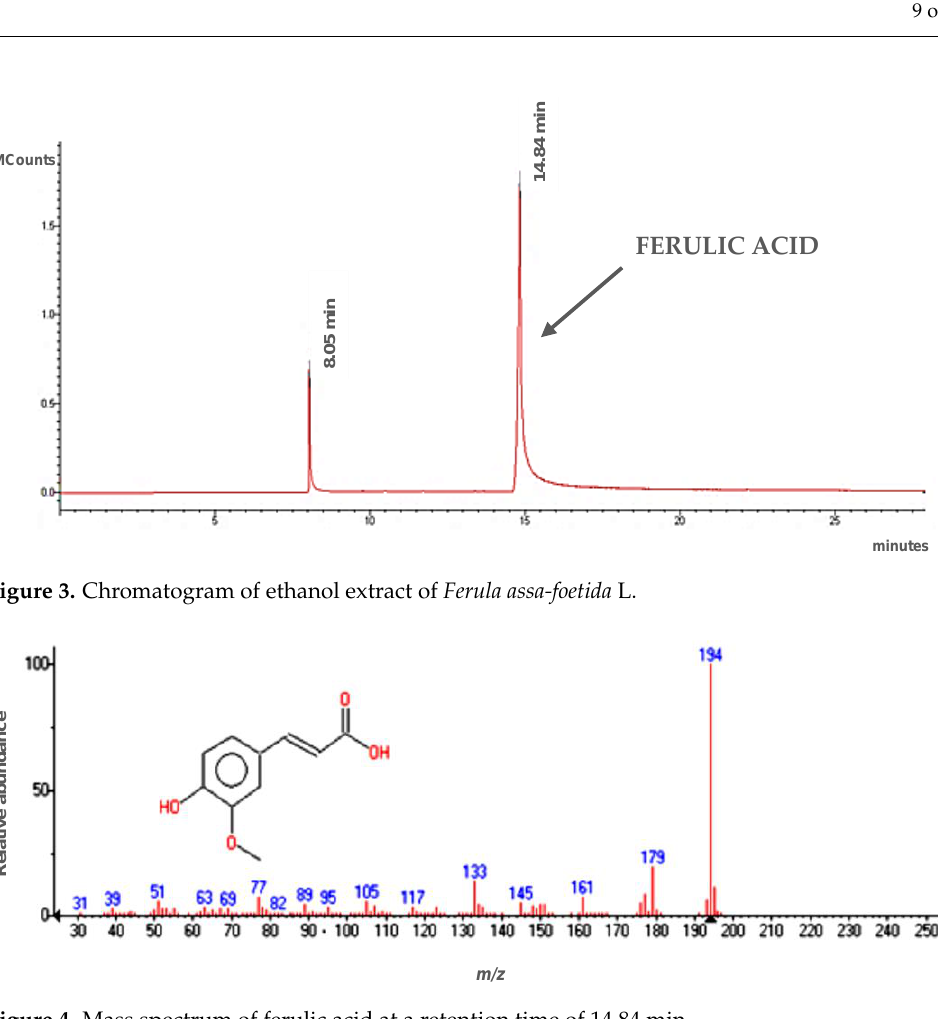
Figure 4. Mass spectrum of ferulic acid at a retention time of 14.84 min.